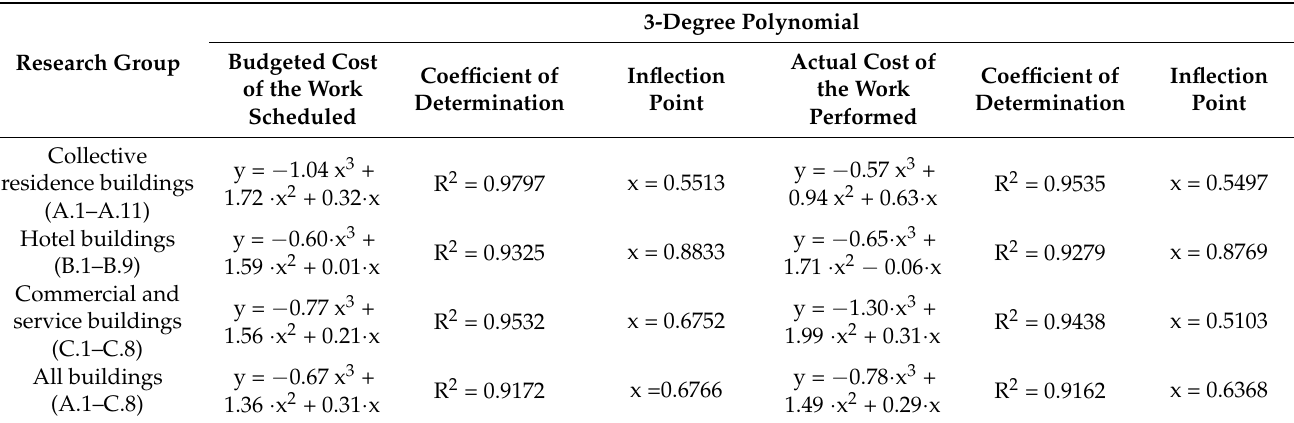
Table 4. A 3-degree polynomial describing the shape of the cost curve (best